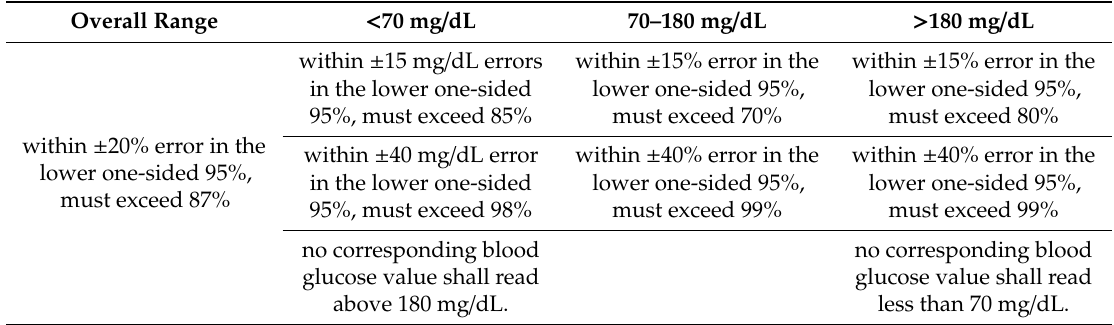
Table 1. Performance requirements of integrated continuous glucose monitoring system (iCGM). Overall